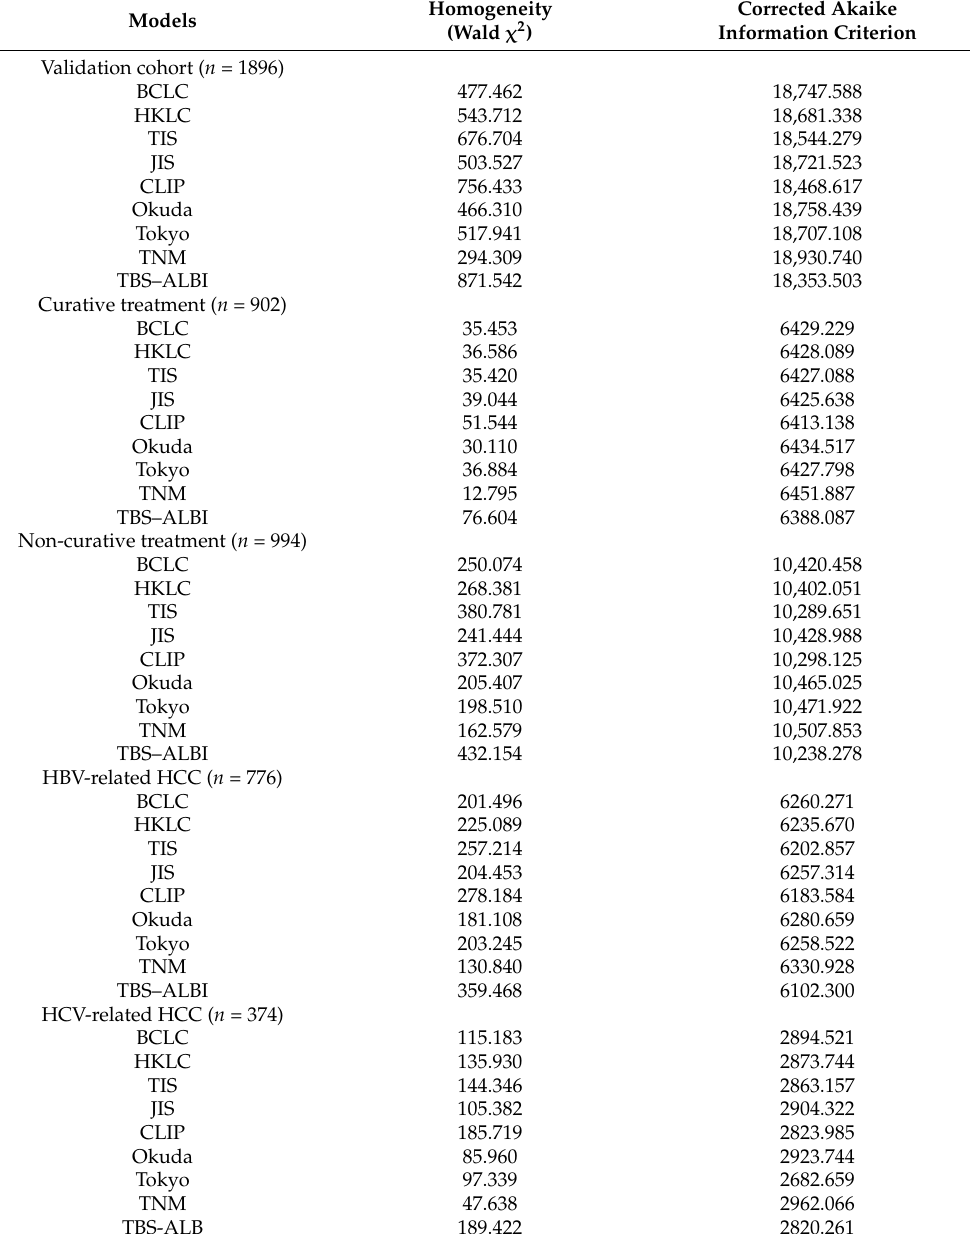
Table 4. Prognostic performance of different staging systems in the validation